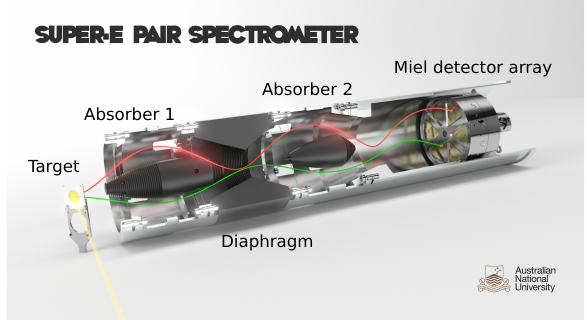
Figure 1. A cut-away, rendered image of the Super-e spectrom- eter. The target is on the left and the Miel detector array is at the right end of the bore of the solenoid. Around the outside of the bore are the superconducting coils – not pictured . Down the cen- tre of the bore are the HeavyMet ba ffl es, in dark grey. Example trajectories of an electron and a positron emitted from the target are shown in red and green.